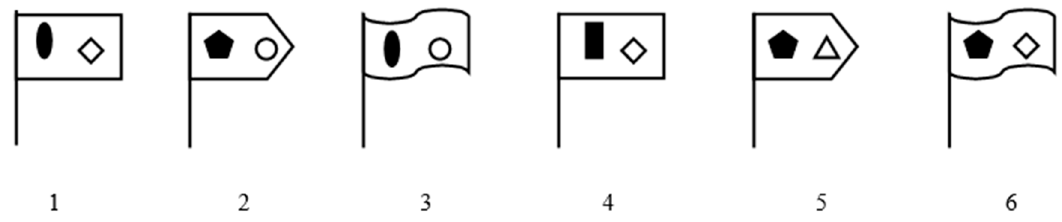
Figure 1. Figure 1. Flags.